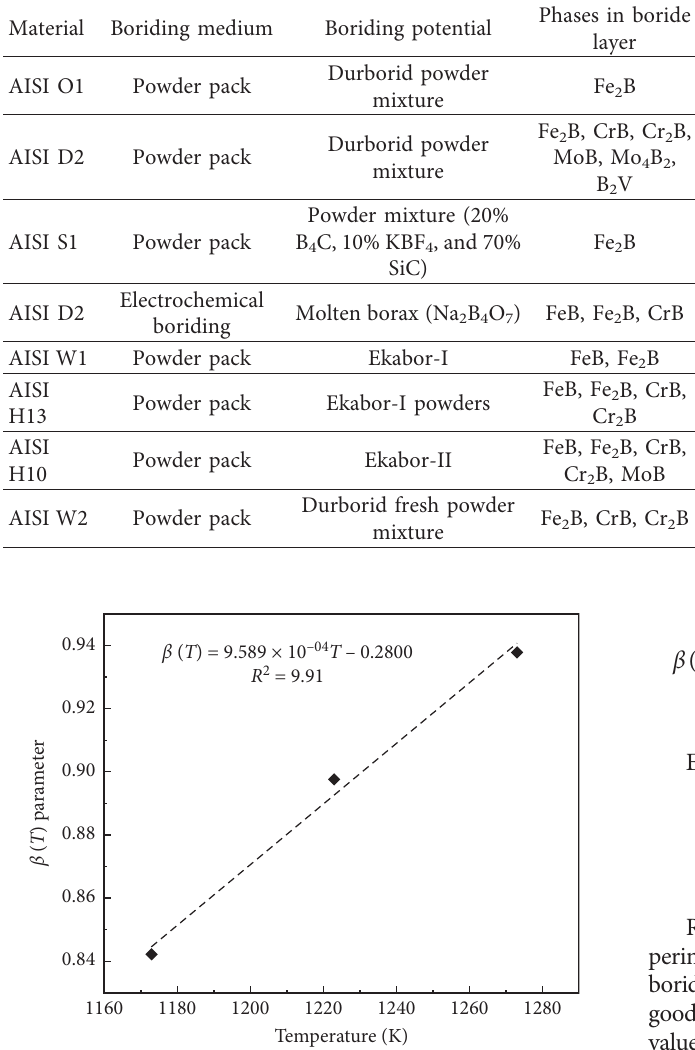
Figure 9: The evolution of β ( T ) parameter versus the boriding